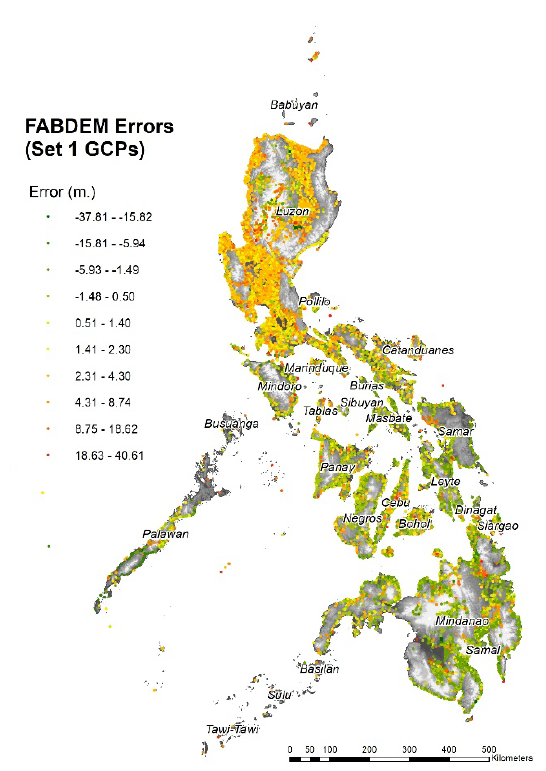
Figure 2. Spatial distribution of FABDEM errors at Set 1 GCP